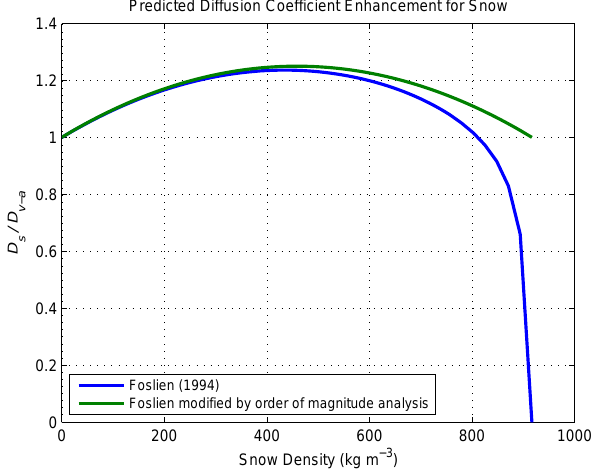
Figure 4. Predicted diffusion coefficient enhancement for snow us- ing the original model of Foslien and a simplified model based on an order of magnitude analysis.